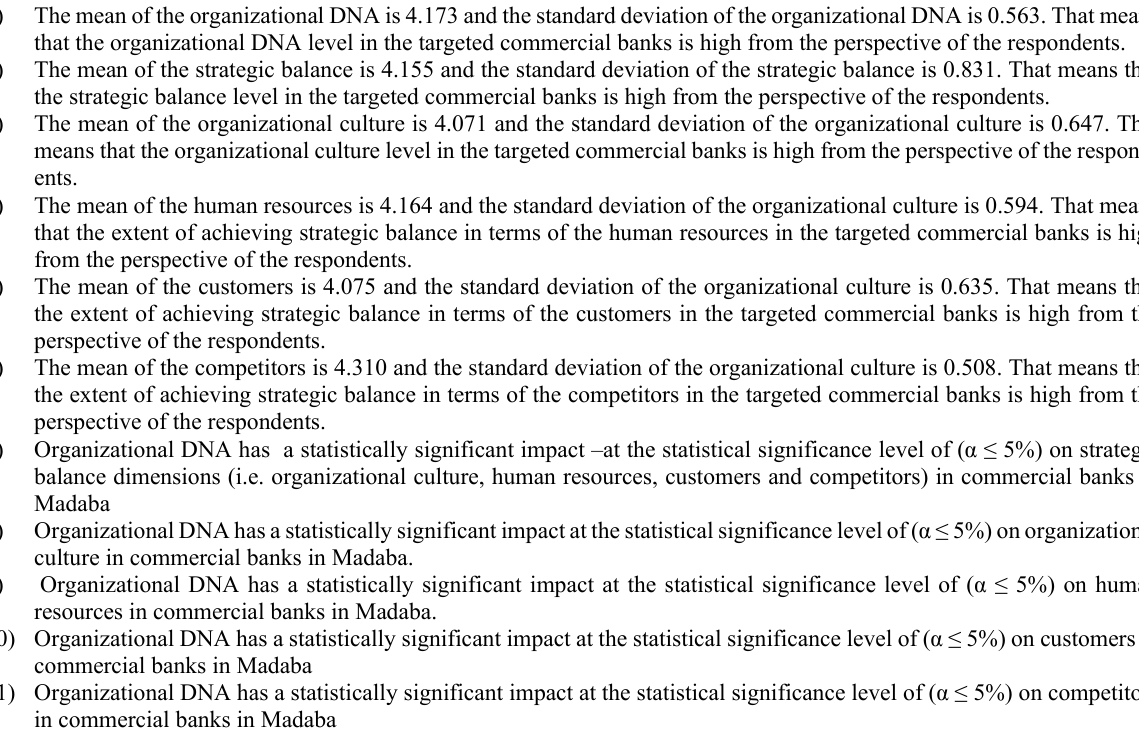
Dependent Variable Model Summary ANOVA